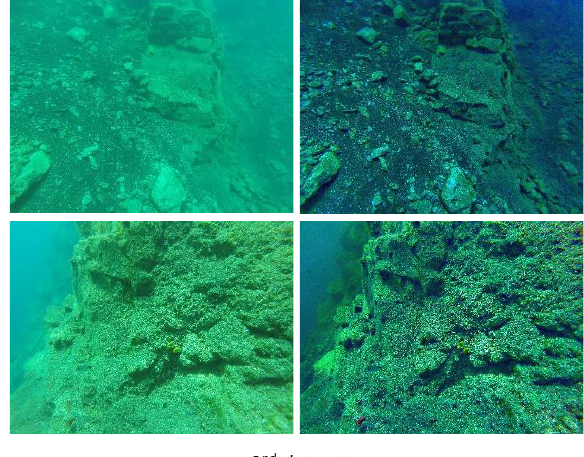
Figure 4. Image pre-processing results. Left : initial images; right : enhanced